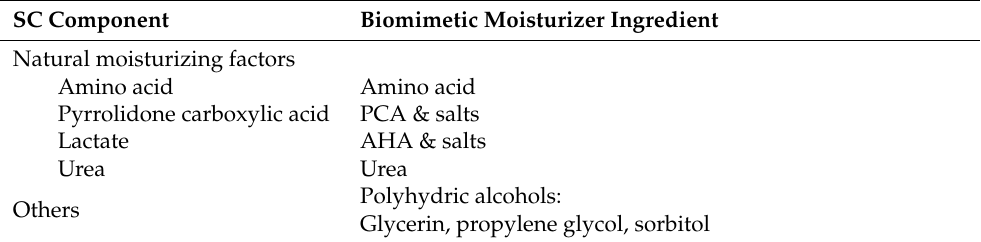
Table 2. Component of skin and moisturizer—hydrophilic humectant. SC